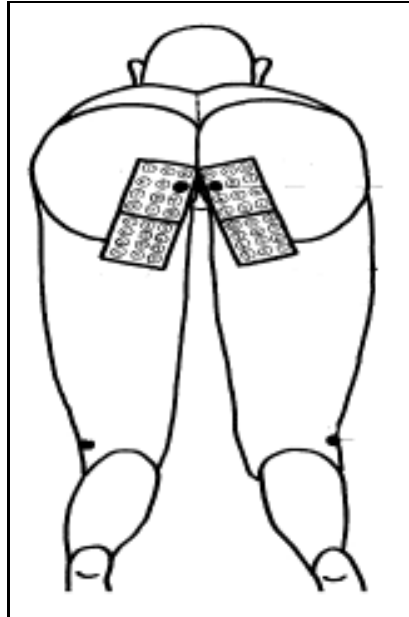
Figure 1: Placing of the